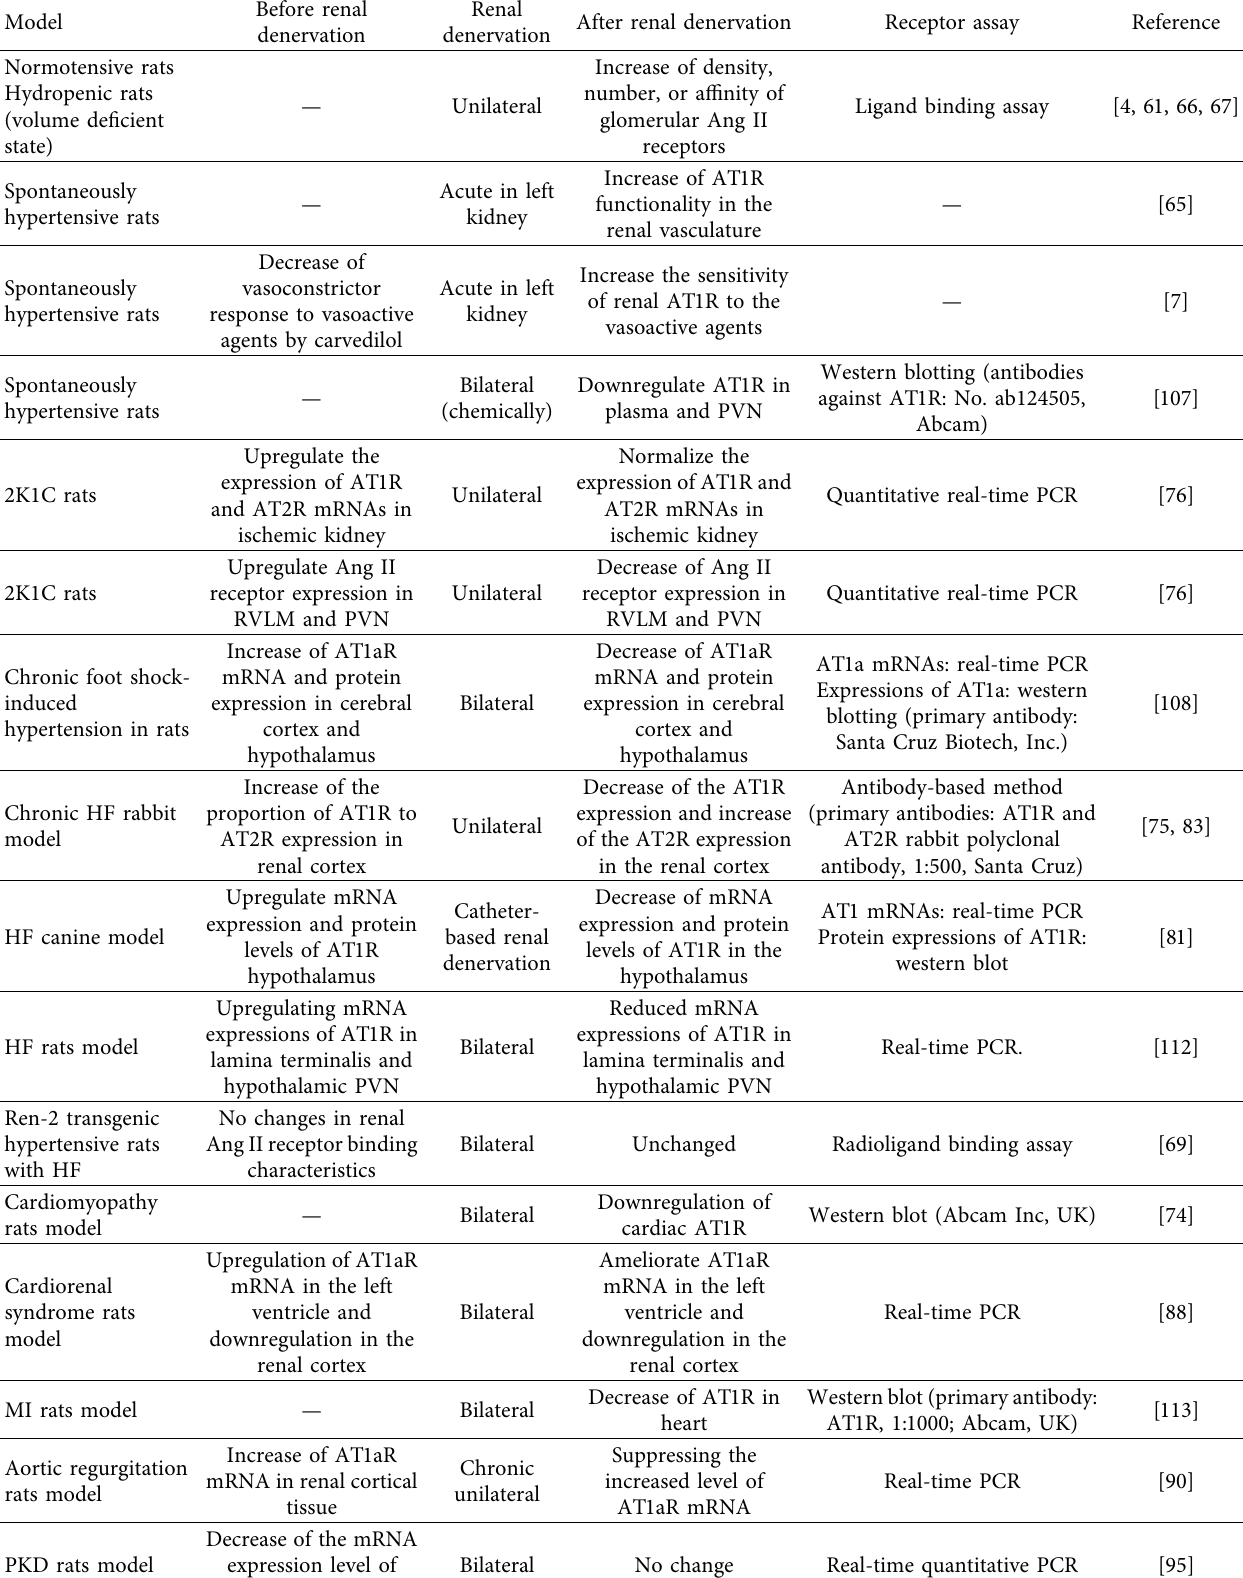
Table 1: The effect of renal denervation on angiotensin II receptors in the